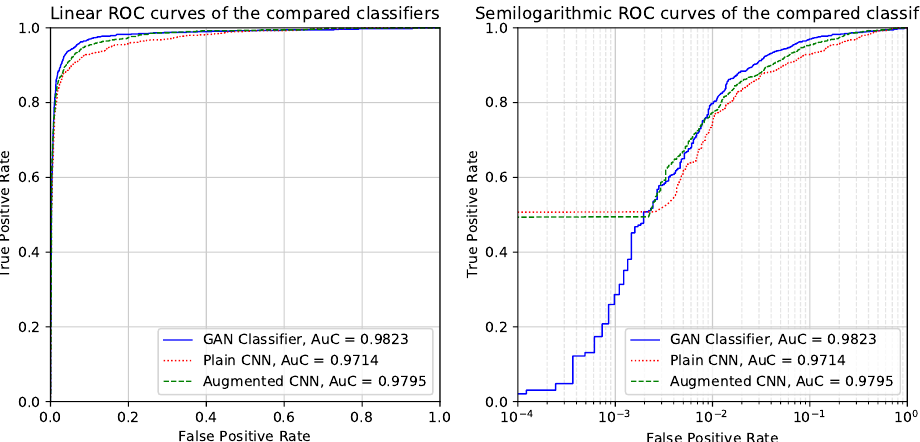
Figure 5. Linear and semilogarithmic ROC curves for each of the three designed models. These curves are calculated by micro-averaging the curves for each